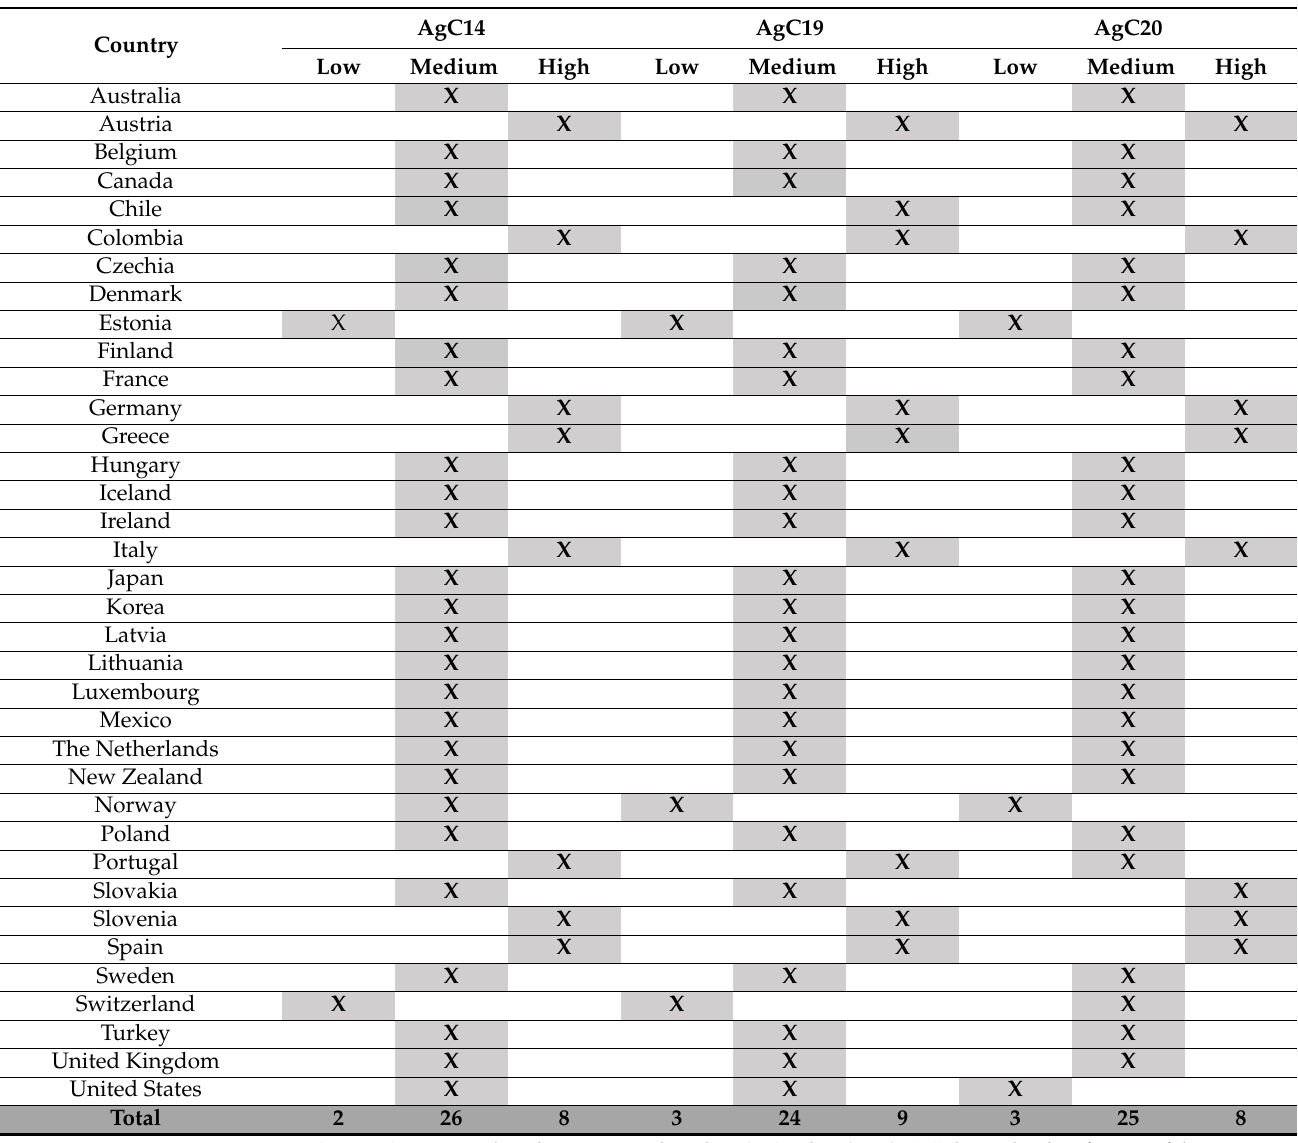
Table 6. Distribution of the categories of the composite indicator in the examined years.